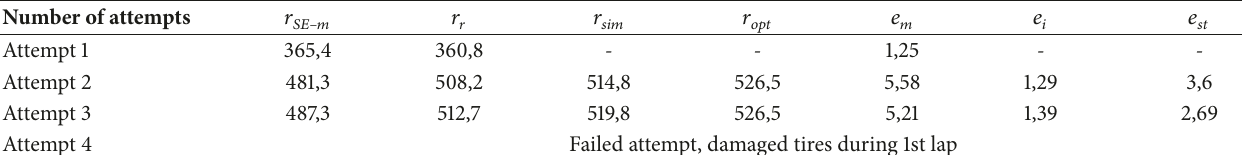
Table 9: Comparison of simulation results with experimental